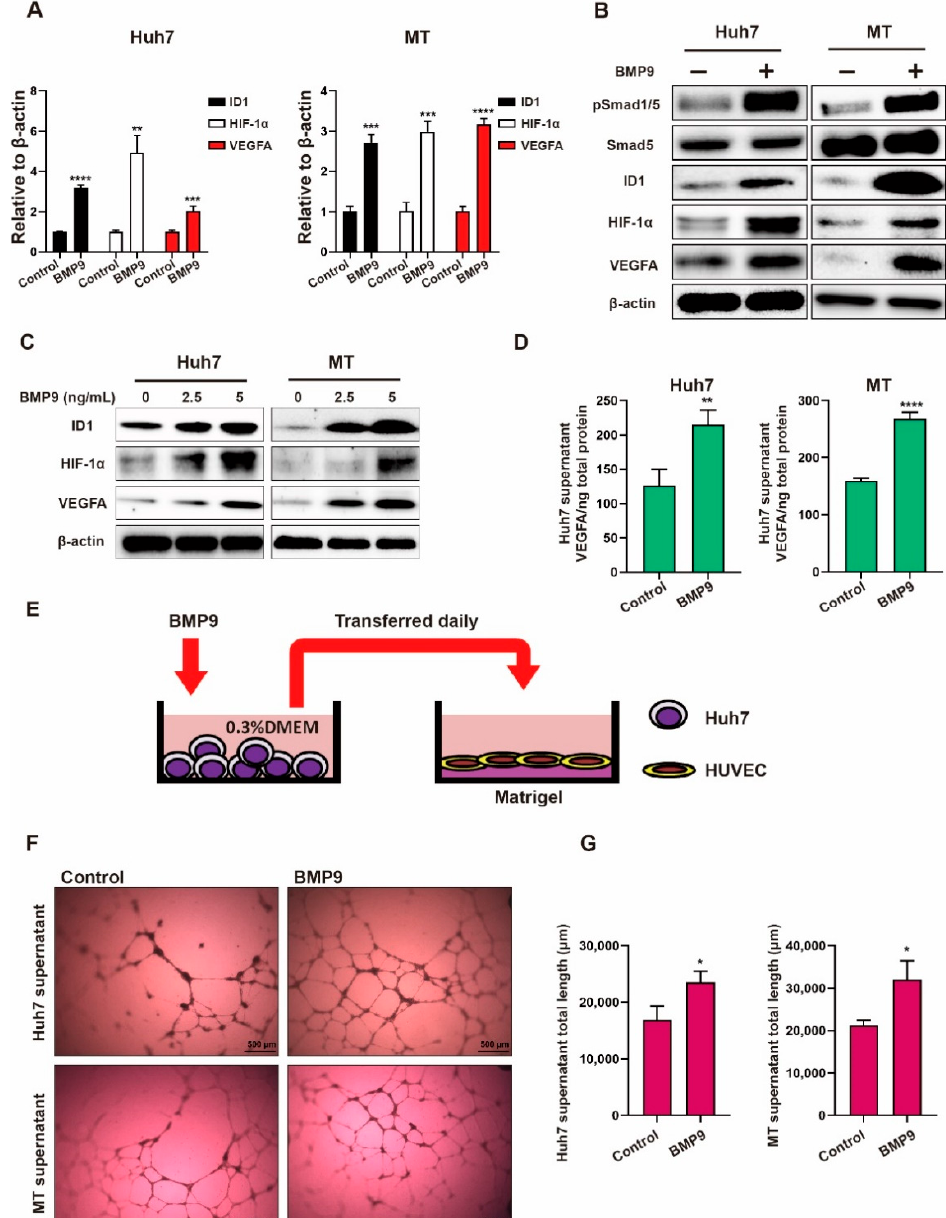
Figure 2. BMP9 activates HIF-1 α /VEGFA signaling in HCC cells. ( A ) Relative gene expression levels of inhibiting DNA-binding protein 1 (ID1), HIF-1 α and VEGFA in Huh7 and MT cells. Cells were treated with dimethyl sulfoxide or BMP9 (5 ng/mL) for 48 h. ( B ) Western blot analysis of pSmad1/5, Smad5, ID1, HIF-1 α and VEGFA expression in Huh7 and MT cells. Cells were treated with dimethyl sulfoxide or BMP9 (5 ng/mL) for 48 h. ( C ) Western blot analysis of ID1, HIF-1 α and VEGFA expression in Huh7 and MT cells treated with different concentrations of BMP9 for 48 h. ( D ) ELISA analysis of VEGFA in the supernatant of Huh7 and MT cell cultures. Cells were treated with dimethyl sulfoxide or BMP9 (5 ng/mL) for 48 h. ( E ) Schematic of the lumen formation assay. ( F ) Representative pictures of the lumen formation assay of human umbilical vein endothelial cell (HUVEC)l culture supernatants were collected from Huh7 or MT cells treated with dimethyl sulfoxide or BMP9 (5 ng/mL) for 48 h. HUVECs were treated with these supernatants for 24 h. ( G ) Lumen length analysis of the lumen formation assay. The error bars represent the SD from at least three independent biological replicates. Student’s t test was used to calculate p values, represented as * p < 0.05; ** p < 0.01; *** p < 0.001; **** p <